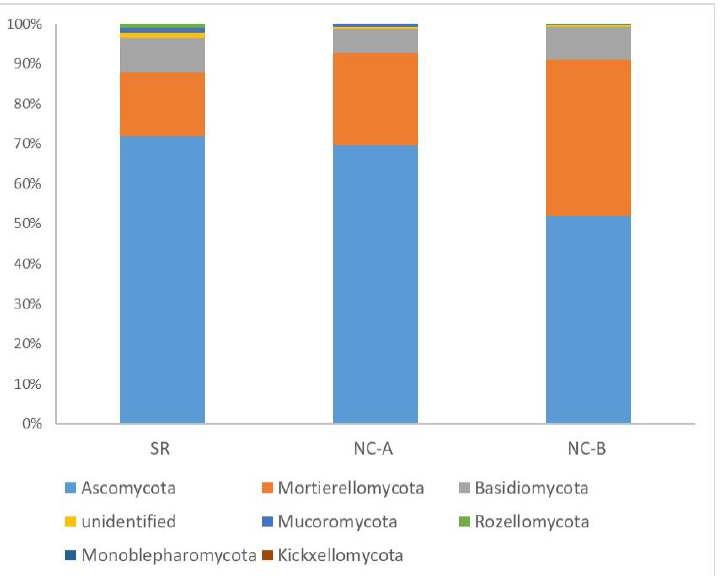
Figure 2. Average soil fungal relative abundances at phylum level of soil samples taken from Soracá (SR) and Nuevo Colón (steep slope plot at higher altitude: NC-A; flat plot at lower altitude: NC-B).